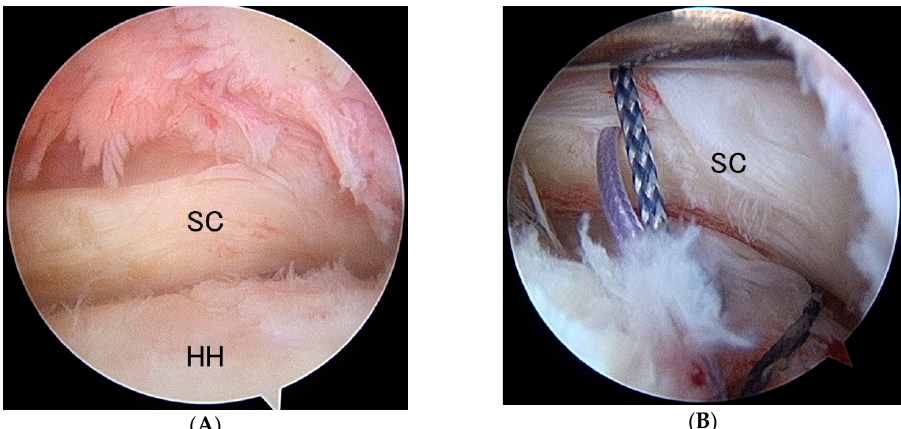
Figure 3. Floating subscapularis. ( A ) Rt. shoulder viewing from the posterior portal. Subscapularis is detached from the lesser tuberosity but is not retracted. The comma structure is preserved and the subscapularis is appearing to be normal at a glance. ( B ) Internal rotation of the shoulder discloses the detachment of the subscapularis from the lesser tuberosity. A suture anchor is inserted on the lesser tuberosity and sutures are applied on the torn subscapularis. SC: subscapularis, HH: humeral head.